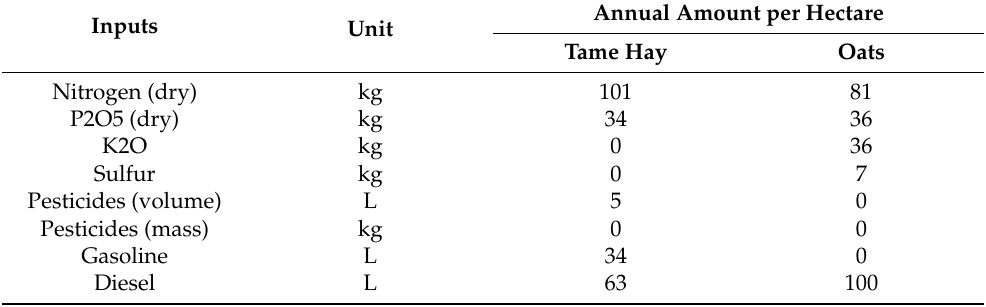
Table A7. Hayden ID.